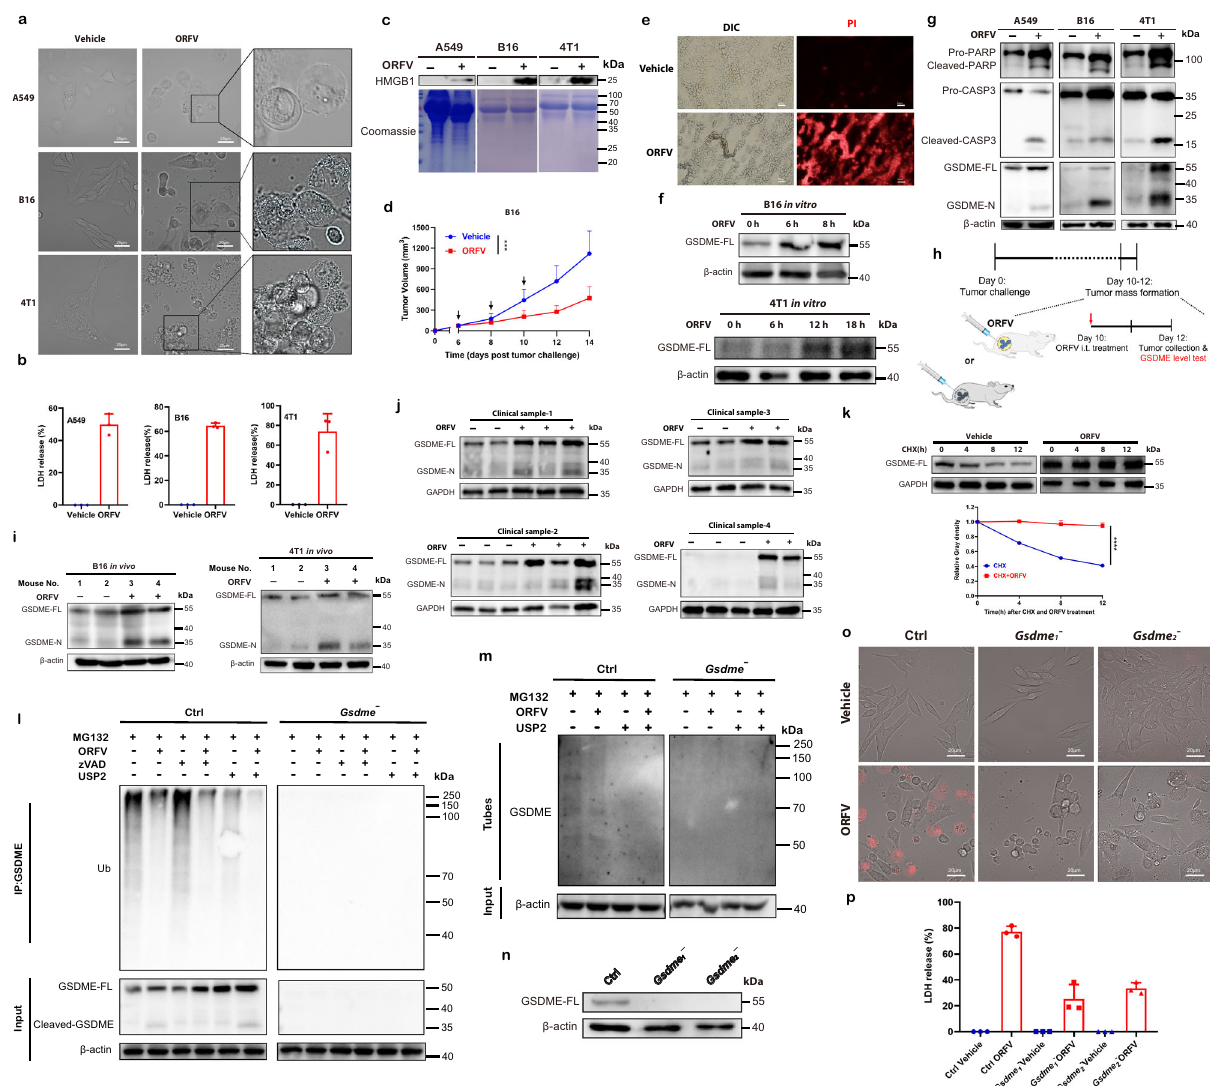
k Detection of GSDME stability. Vehicle or ORFV-treated B16 cells were incubated with 100 μ M cycloheximide before cell collection. Relative Gray density analysis is at the bottom ( n =3) ( P <0.0001). l Immunoprecipitation analysis of GSDME ubi- quitination in Ctrl and GSDME-depleted B16 cells upon ORFV, zVAD, and USP2 treatment for 12h in the presence of 10 μ M MG132. m Ubiquitinated GSDME was identi fi ed after pulldown with TUBE agarose beads to trap polyubiquitinated